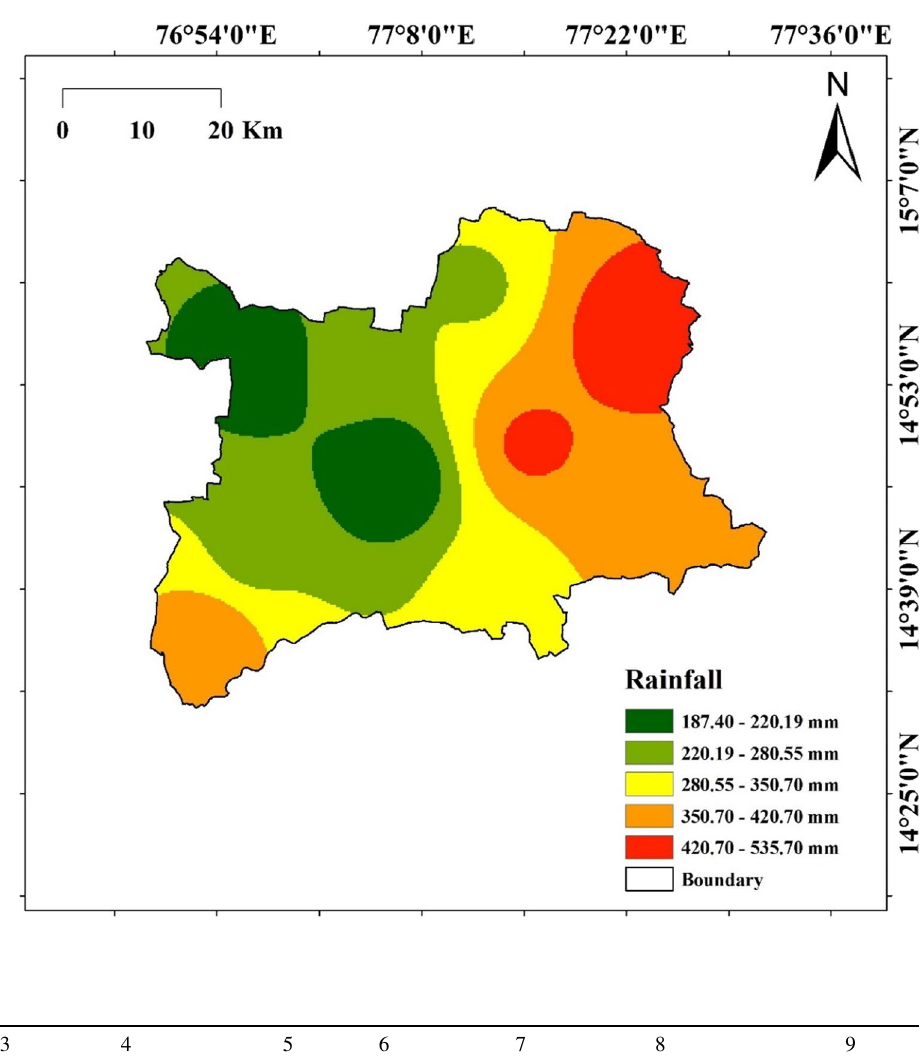
Fig. 10 Rainfall